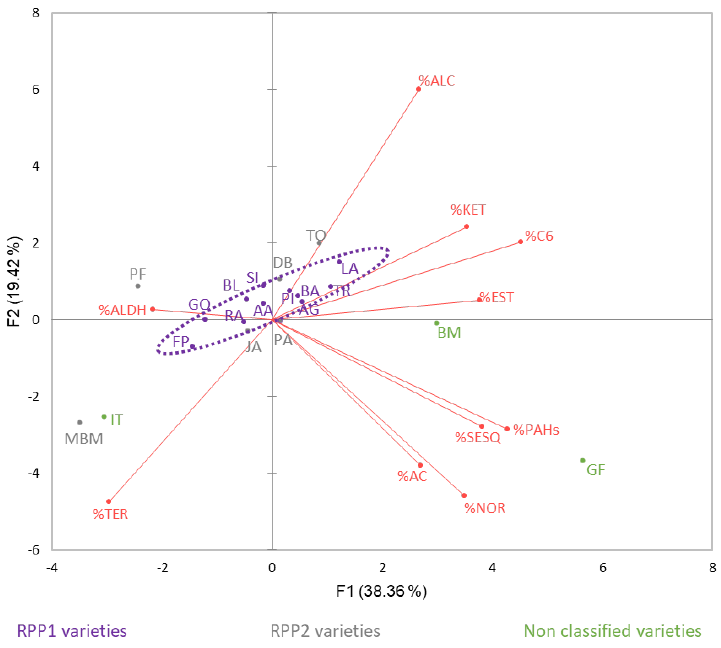
Figure 3. Principal component analysis of glicosidically bound aromatic fraction profile (percent- age) of grapes. NOR: C 13 -norisoprenoids, AC: acids, EST: esters, KET: ketones, PAHs: